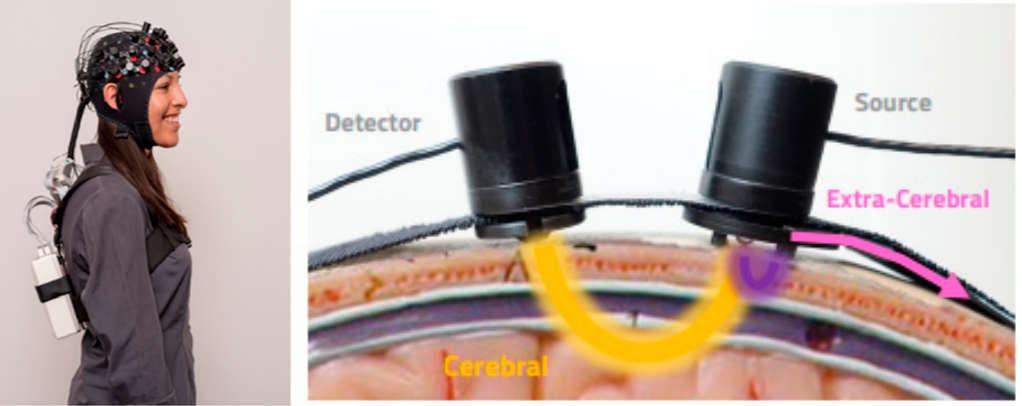
Figure 1. NIRSport2 device from NIRx as a small a backpack ( left ). NIRS source-detector placement ( right ). Photo courtesy: https://nirx.net/ (accessed on 30 March 2021).